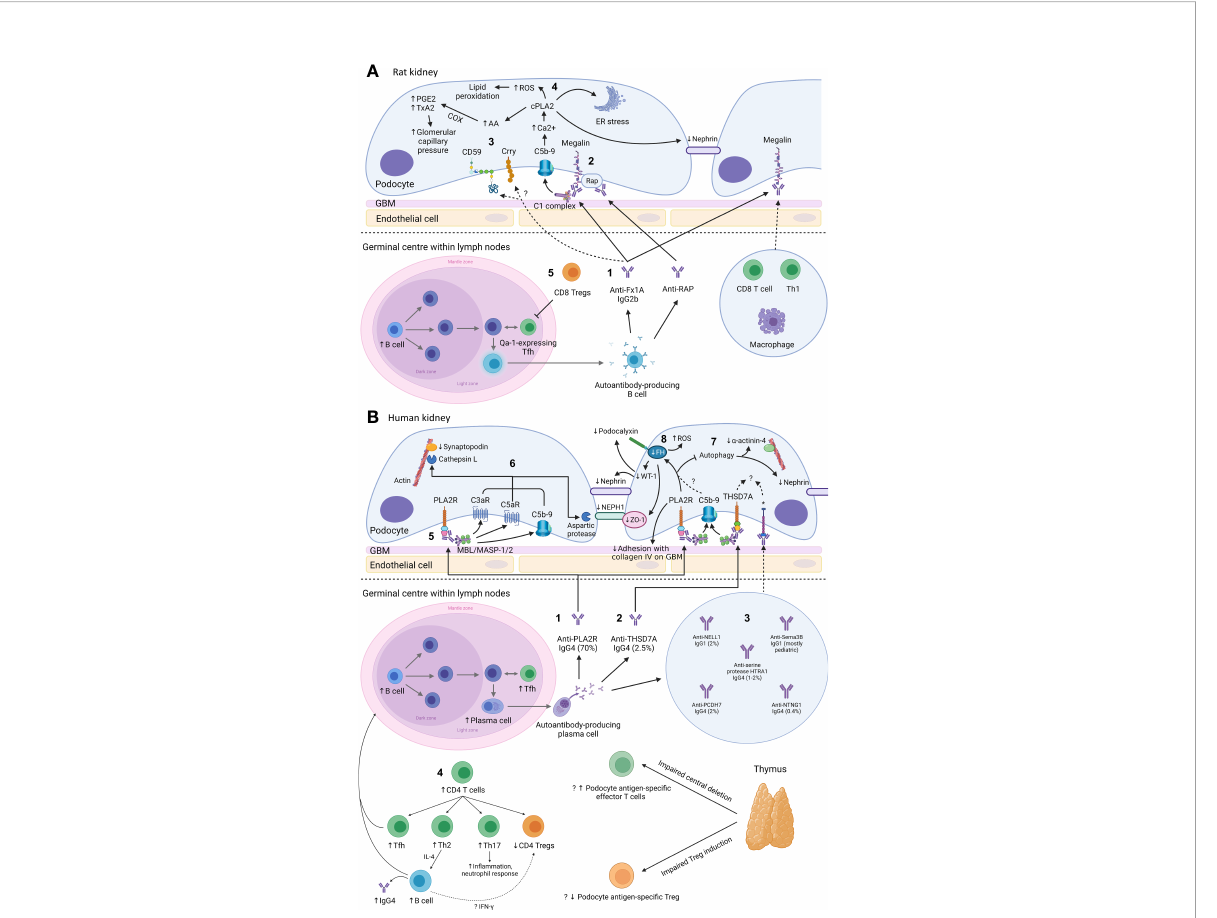
FIGURE 1 Mechanism of podocyte injury in Heymann nephritis (A) and primary membranous nephropathy (B) Created with BioRender.com. GBM, glomerular basement membrane; ROS, reactive oxygen species; cPLA2, cytosolic phospholipase A2; PGE2, prostaglandin E2; TxA2, thromboxane A2; COX, cyclo-oxygenase; AA, arachidonic acid; ER, endoplasmic reticulum; RAP, receptor associated protein; Treg, regulatory T cell; Th1, CD4 + T helper-1 cell; Tfh, CD4 + T follicular helper cell; FH, fumarate hydratase; WT-1, Wilms tumor-1; PLA2R, M-type phospholipase A2 receptor 1; C3aR, C3a receptor; C5aR, C5a receptor; MBL, mannan-binding lectin; MASP, mannan-binding lectin serine protease; ZO-1, zonula occludens-1; THSD7A, thrombospondin type-1 domain-containing protein 7A; NELL1, neural epidermal growth factor-like 1 protein; Sema3B, semaphorin 3B; PCDH7, protocadherin 7; HTRA1, high temperature requirement A serine peptidase 1; NTNG1, netrin G1; Th2, CD4 + T helper-2 cell; Th17, CD4 + T helper-17 cell; IFN- g , interferon- g ; *cognate antigen for anti-NELL1, anti-Sema3B, anti-PCDH7,